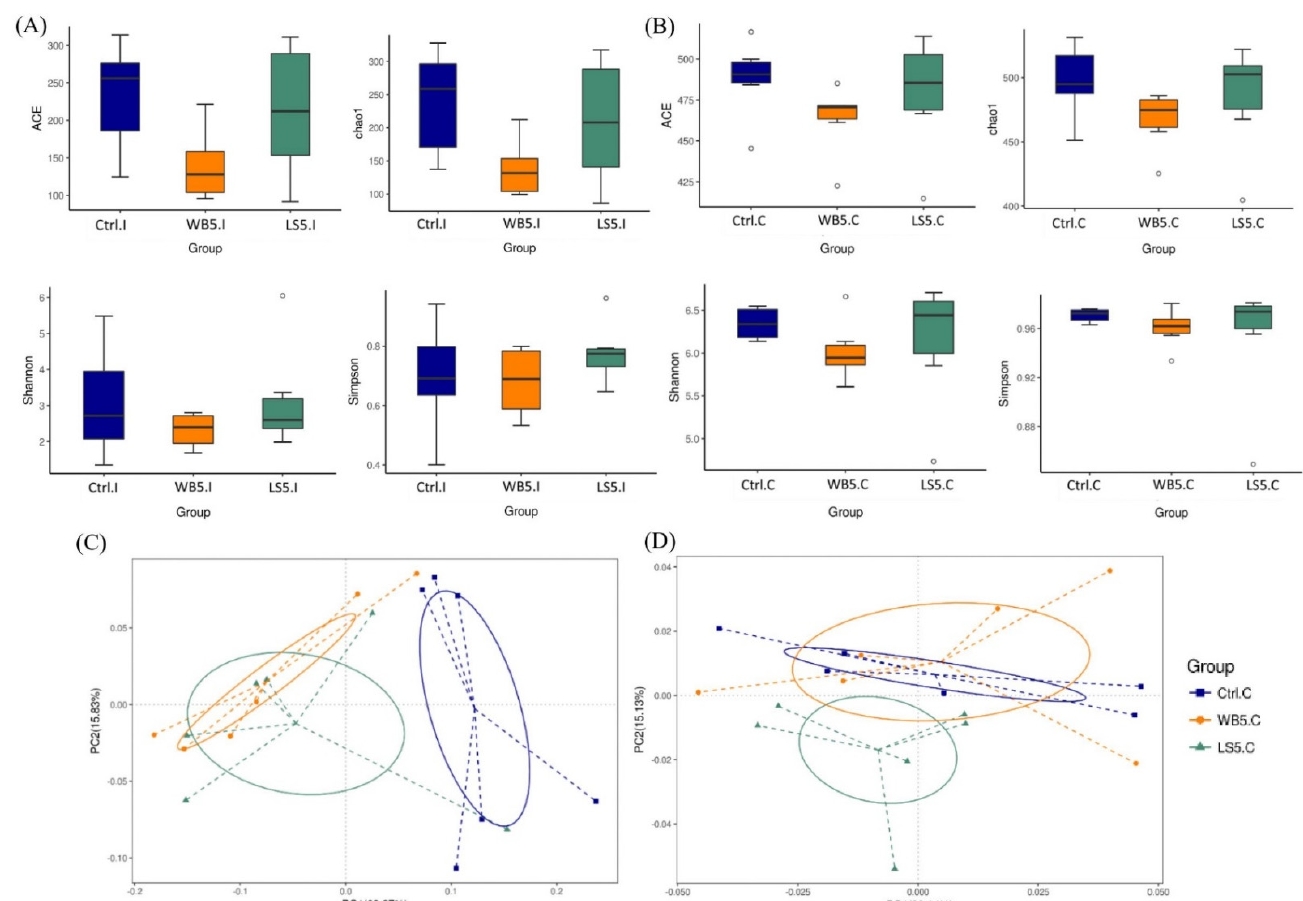
Figure 1. Diagram of alpha diversity in the ileum ( A ) and cecum ( B ), as well as the weighted PCoA showing beta diversity in the ileum ( C ) and cecum ( D ) of 35-day-old broilers. Ctrl: control group, WB5: broilers supplemented with 5% wheat bran, LS5: broilers supplemented with 5% Laetiporus sulphureus wheat bran. Results are means of six samples obtained from the individual birds of each of the control and experimental groups.